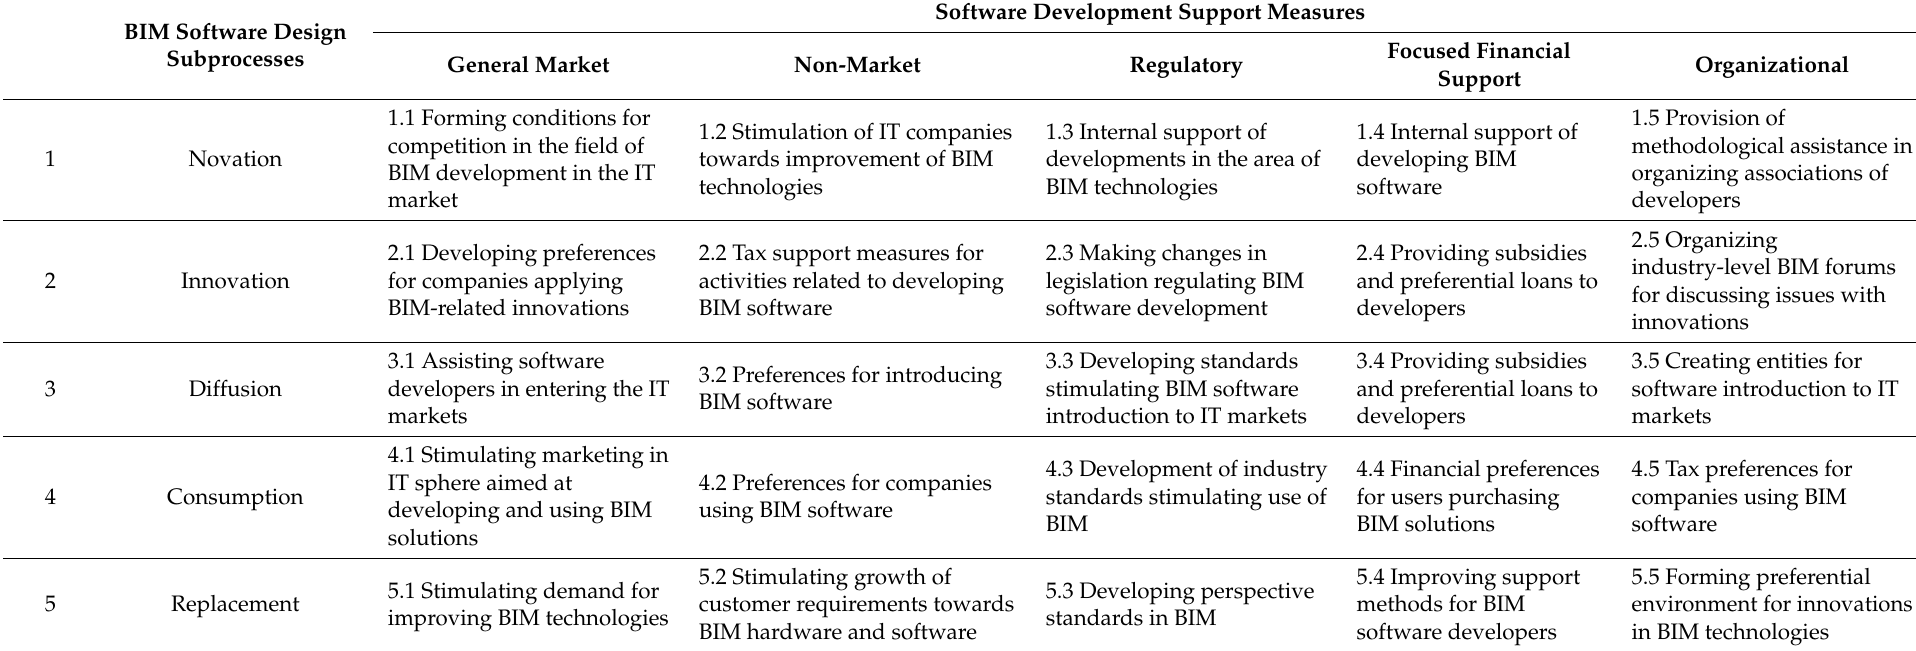
Table 1. Managing subprocesses occurring at BIM software development companies and public–private support measures for accelerated development and implementation of BIM in development